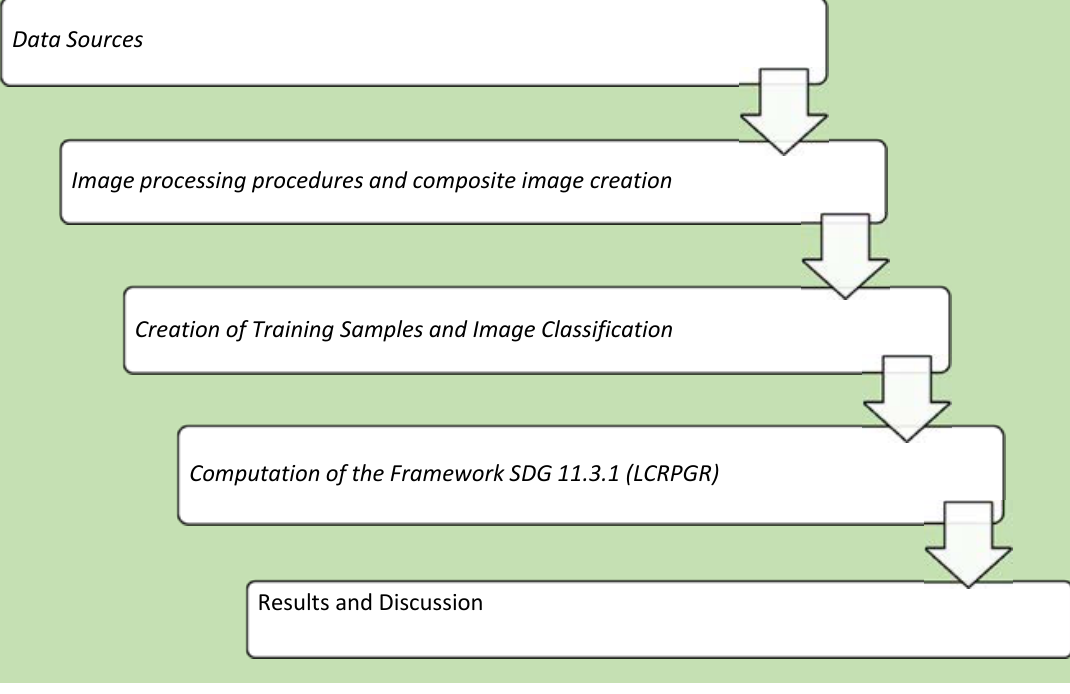
Fig. 2: Flow method Chart Modified from Yohanna et al. (2015).